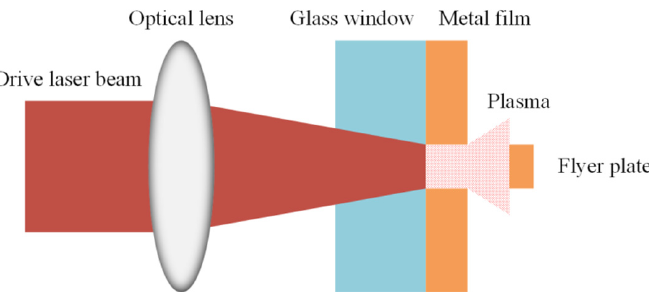
Figure 6. Schematic layout of laser ‐ driven flyer.